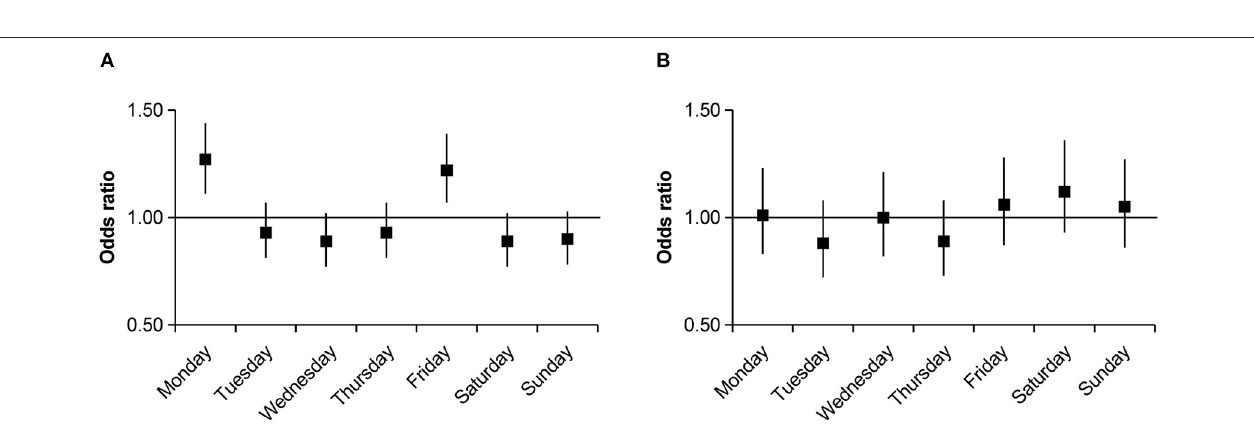
FIGURE 3 | Odds ratios with 95% confidence intervals for weekly variations of intracerebral hemorrhage occurrence stratified by drinking and smoking group compared with the average numbers. (A) Drinking group. (B) Non-drinking group. (C) Smoking group. (D) Non-smoking group.